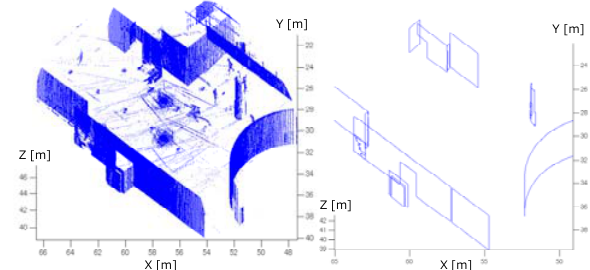
Figure 11. Point cloud (left image) and polygon extraction result (right image) Processing time for the panoramic image conversion and polygon extraction was several minutes in total for each viewpoint using an Intel core i7 2.80 GHz processor with MATLAB (single